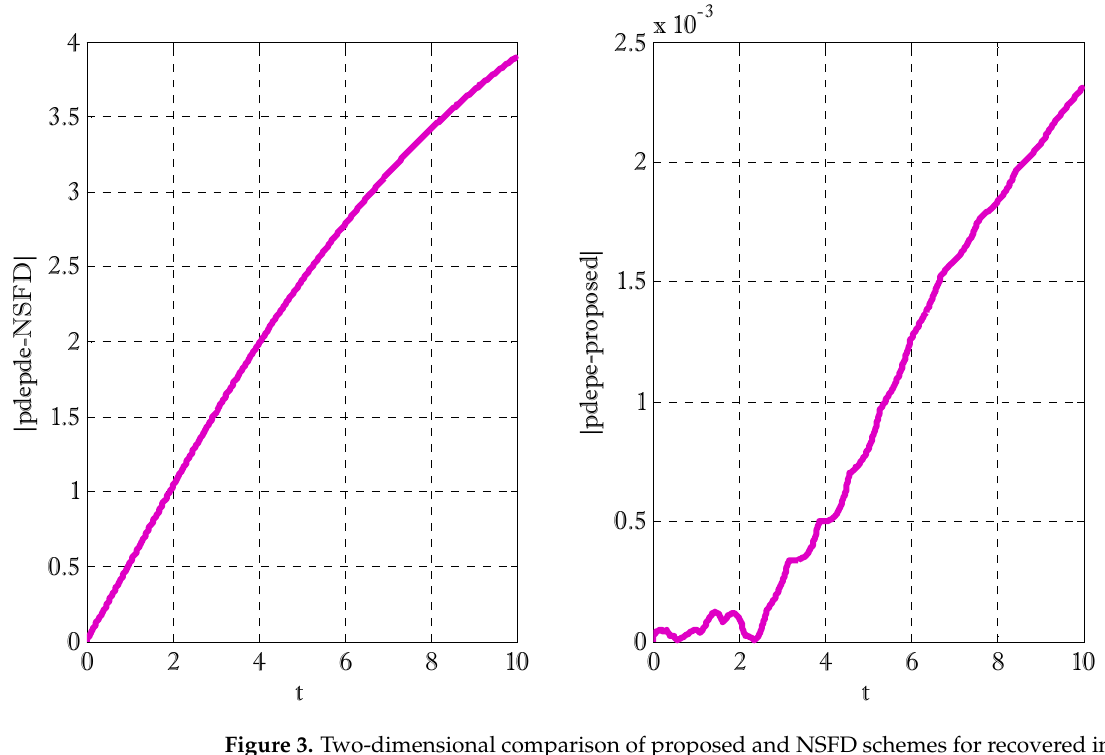
Figure 3. Two-dimensional comparison of proposed and NSFD schemes for recovered individuals using L = 10, N x = 50, N t = 700, α 1 = 0.5, β = 0.3, γ = 0.4, σ = 0.1, µ = 0.1, d 1 = d 2 = d 3 = d 4 = d 5 = 0.9, α = 1.